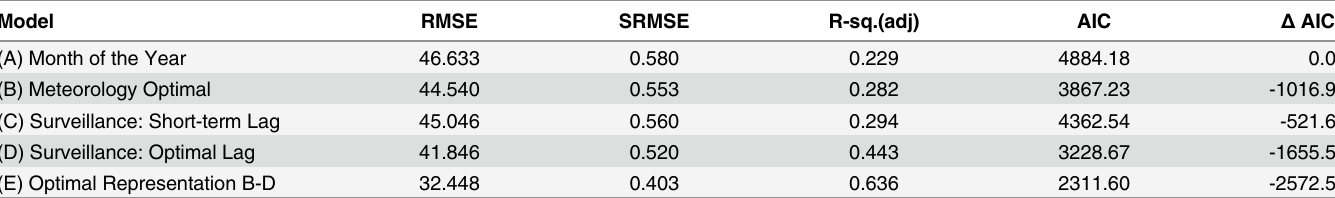
Table 1. Predictive Performance Statistics